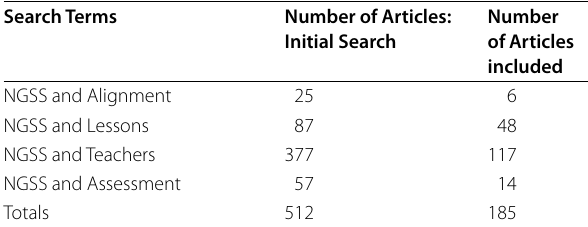
Table 1 Literature Search Terms and Number of Articles Meeting